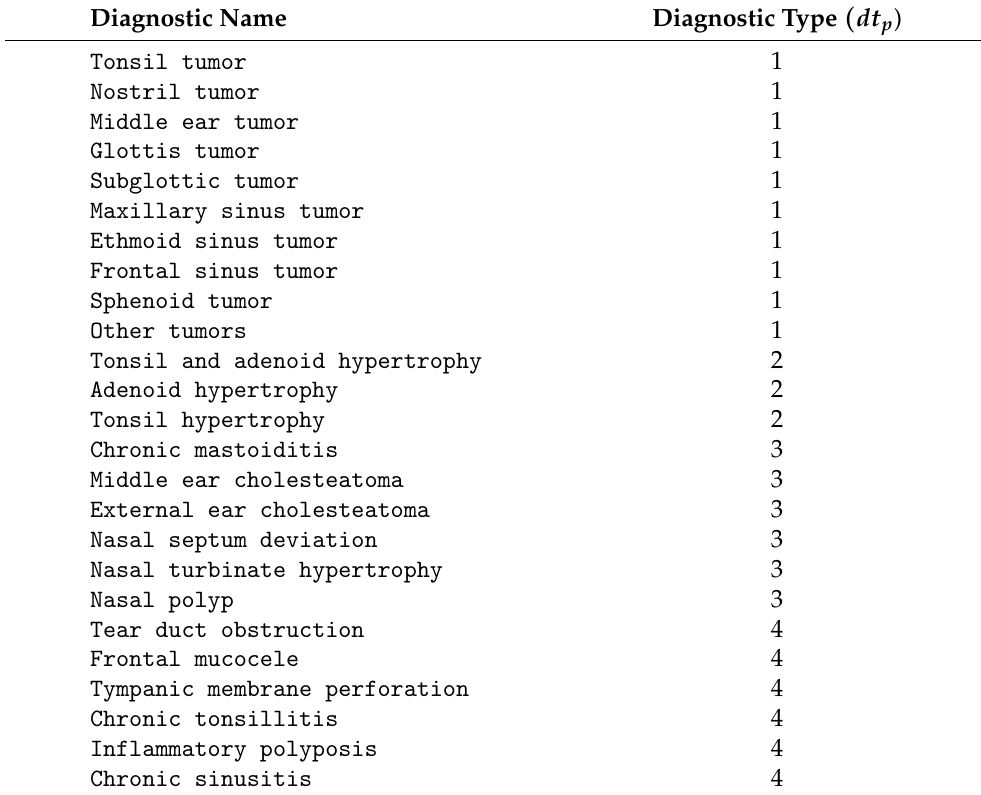
Table 6. Diagnostic Types, dt p , most common admissions to SWL in ENT units, and defined in consensus by the health